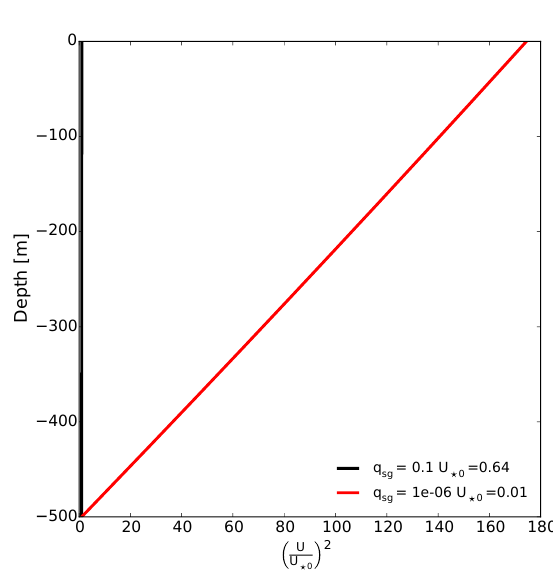
Figure A2. Evolution of U for an initial velocity of U (cid:63) . The plume with a small discharge ( q sg = 10 − 6 m 2 s − 1 ) will accelerate strongly (red line, U (cid:63) = 0 . 14ms − 1 ) while the plume velocity with larger discharge remains almost constant (black line, q sg = 0 . 1m 2 s − 1 , U (cid:63) = 0 . 63ms − 1 ).